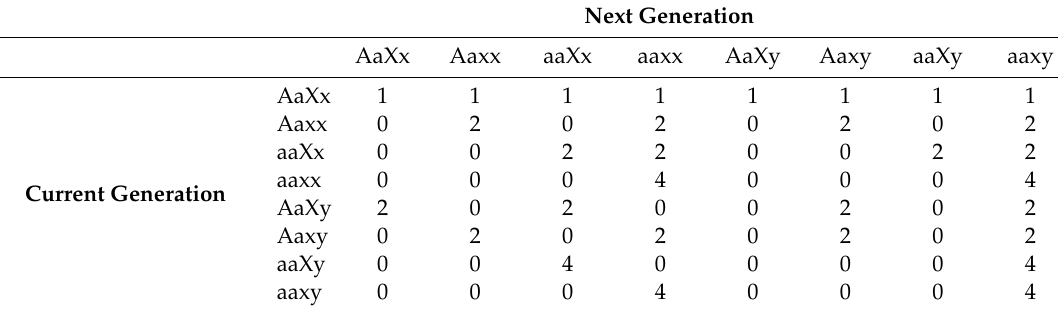
Table 1. Two-locus transition probabilities (multiples of 1 / 8) between parent (row) and offspring (column). Next Generation